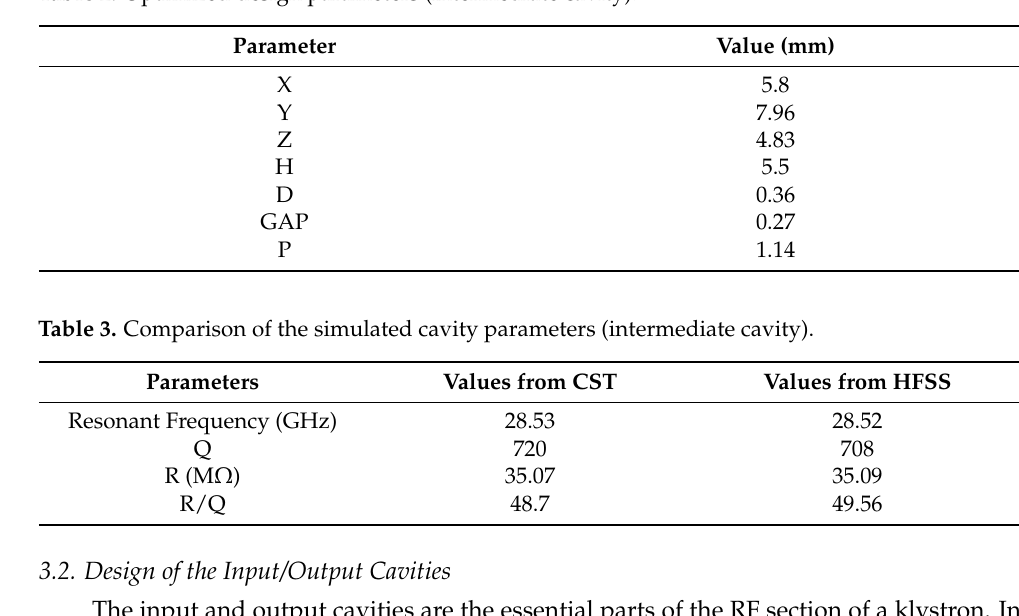
Table 2. Optimized design parameters (intermediate cavity).